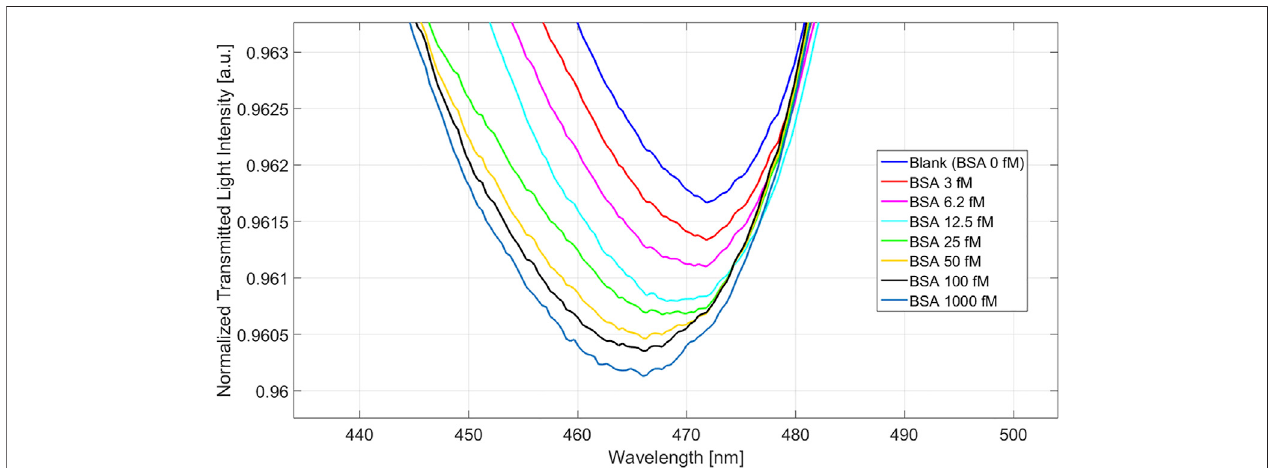
FIGURE 6 | Nanoplasmonic spectra obtained at different concentrations of BSA in buffer solution.